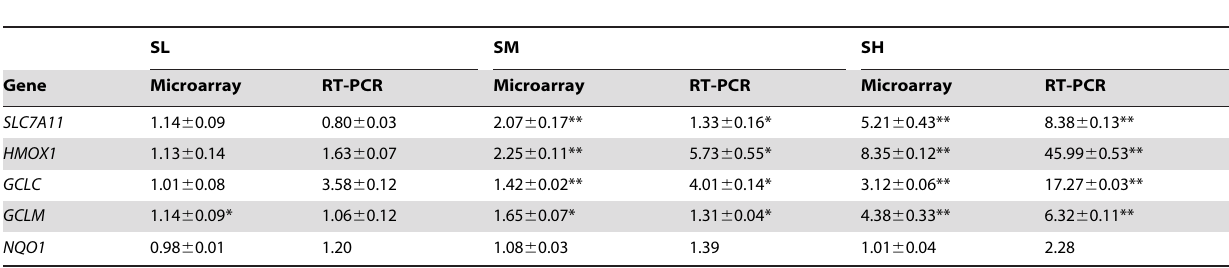
Table 6. The gene expression fold changes of RT-PCR in comparison with the